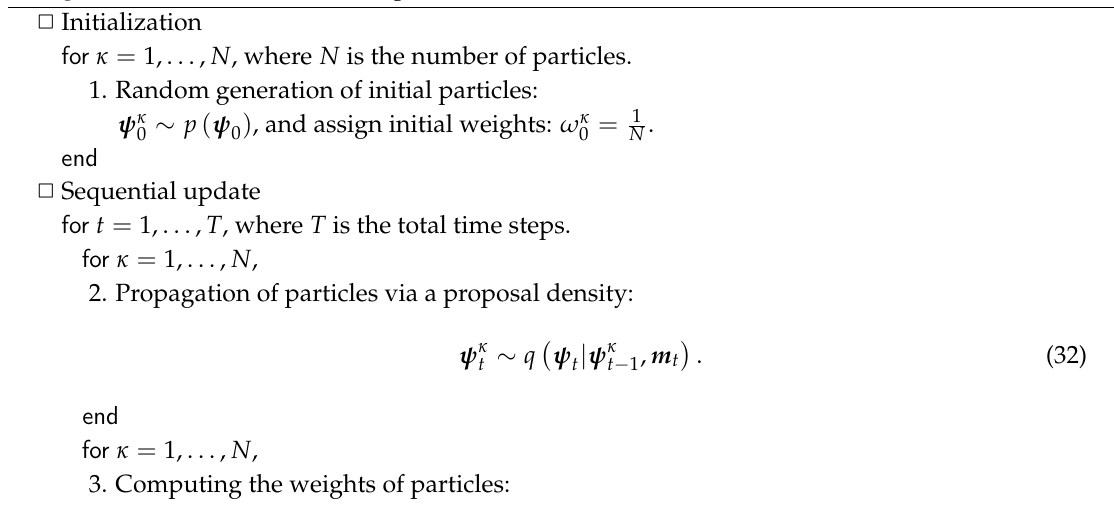
Algorithm 1: The minimax PF algorithm for the standard PF in wireless sensor